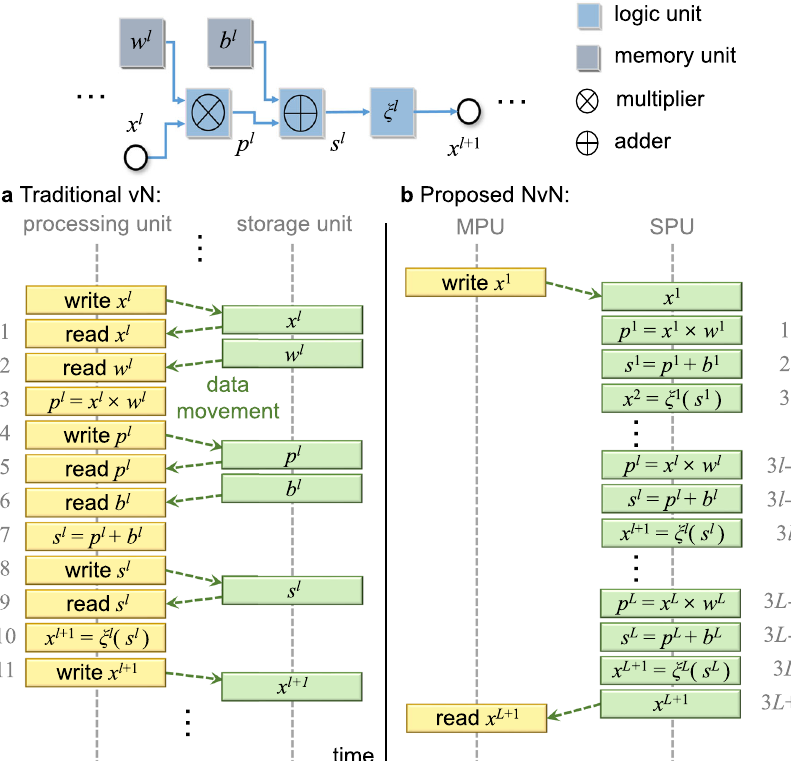
Fig. 9 Schematic comparison of calculation step between vN and NvN architecture. Equation (7) is used as an example to indicate the difference between traditional vN architecture ( a ) and proposed NvN architecture ( b ) based on the processing-in-memory (PIM) technology. Here x l , w l , b l , and ξ l are input, weight, bias, and nonlinear activation function of the l th layer, respectively; p l = x l × w l ; s l = b l + p l